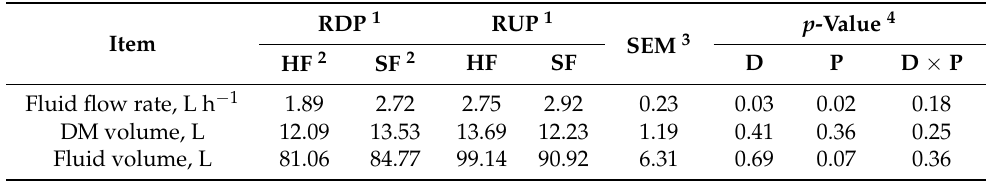
Table 4. Impacts of supplementation on rumen kinetics of 2- and 3-year-old beef cows fed low-quality forage.